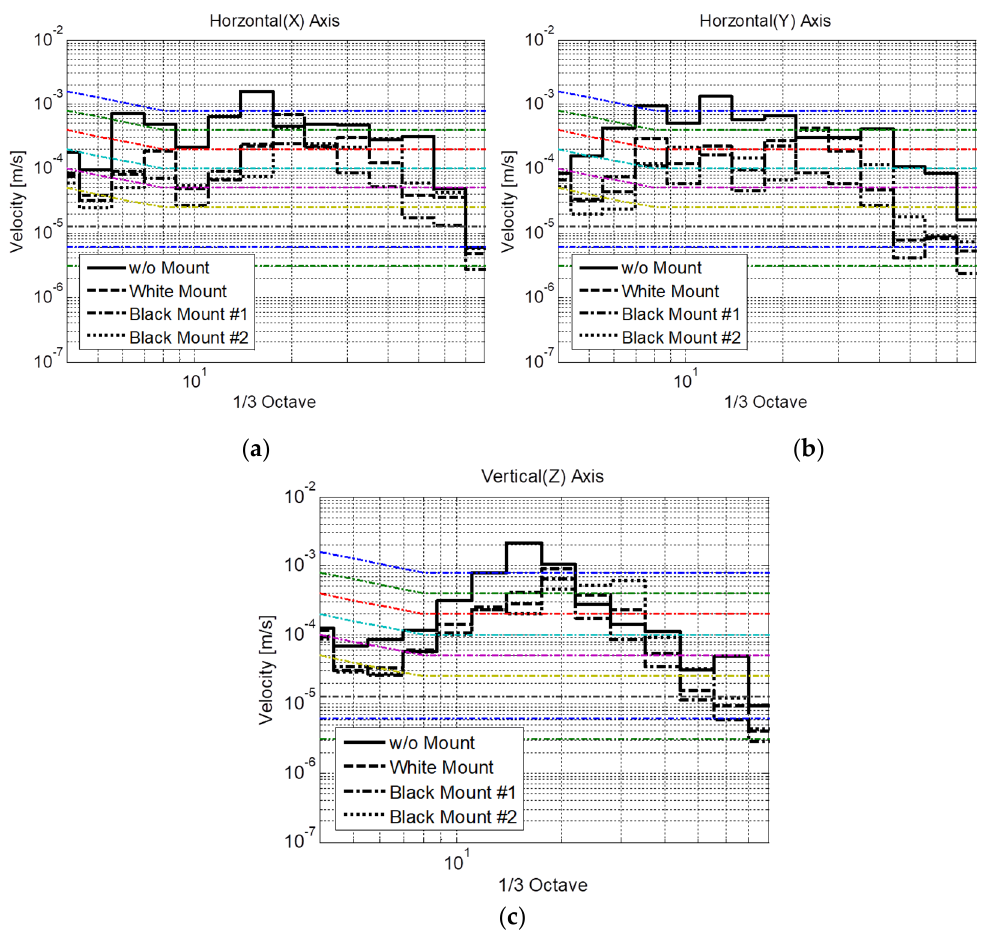
Figure 11. Environmental vibration in the directions of ( a ) x- , ( b ) y- , and ( c ) z -axes compared to the generic vibration criteria with three different types of mounts.